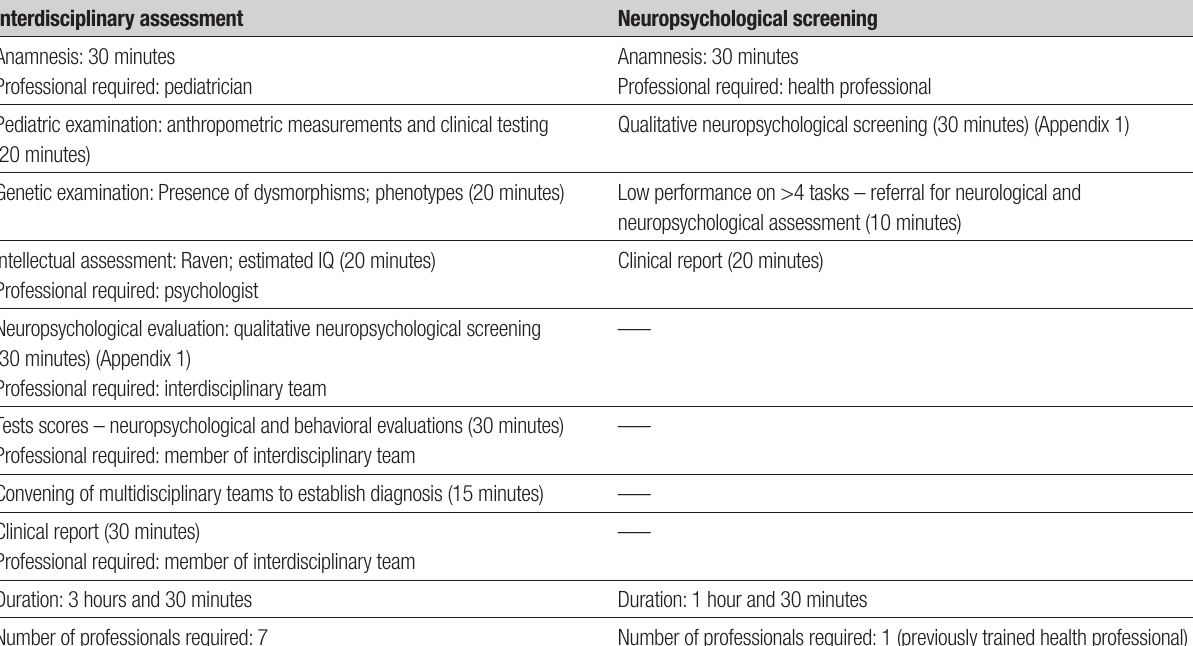
Table 4. Comparison of procedures and durations of interdisciplinary assessment model and qualitative neuropsychological